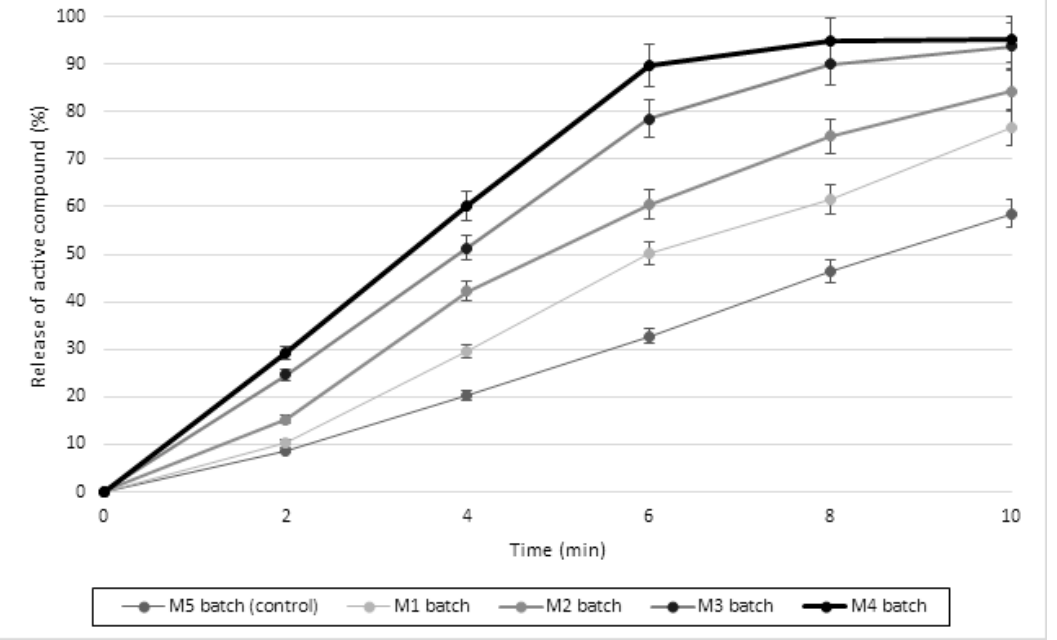
Figure 4. In vitro dissolution profile of orodispersible meloxicam tablets formulated with different amounts of psyllium ( Plantago ovata Forsk) husk powder.